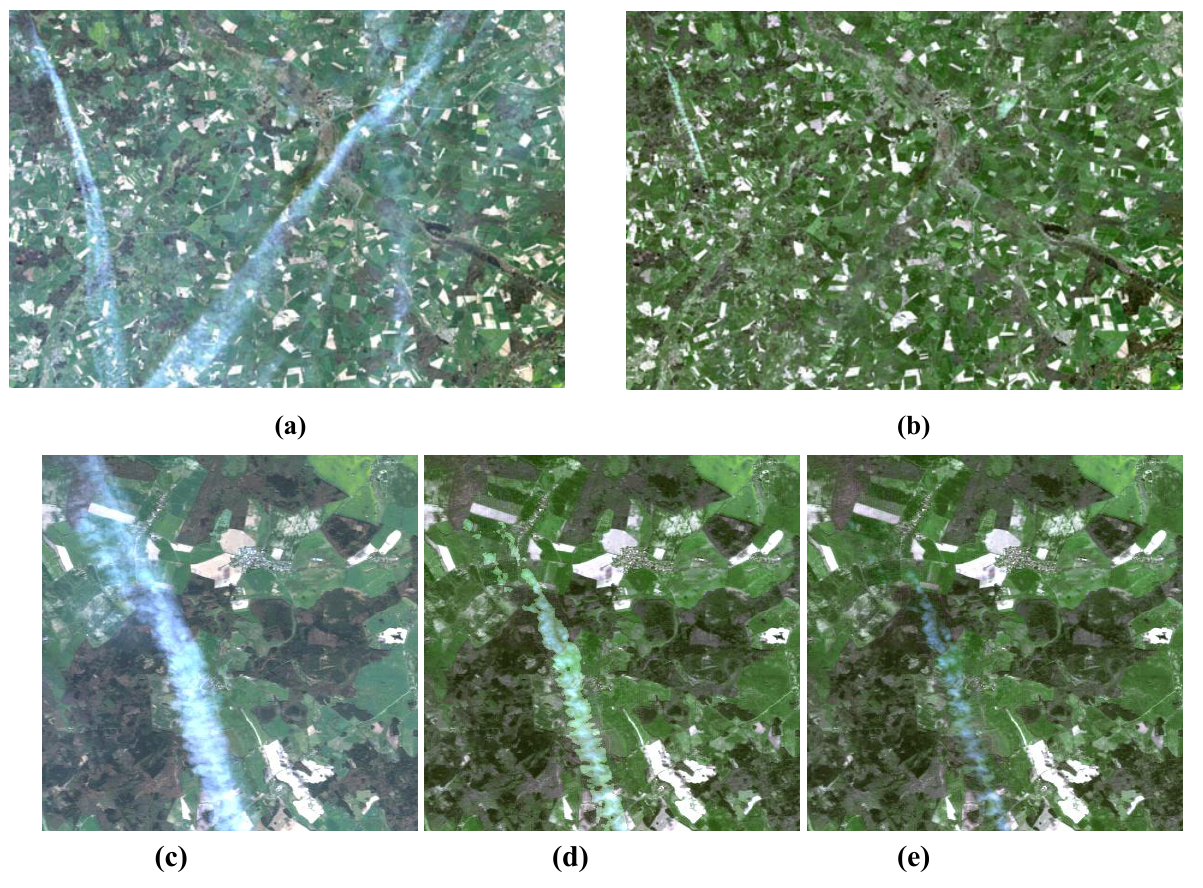
Figure 2 . (a) original scene RBG=3,2,1, (b) after atmospheric correction with haze removal; (c) zoom of (a); (d) zoom of (b) with simple water mask, i.e. ρ (NIR)=0.05; (e) same as (d) but with improved water mask, i.e.; relationships in